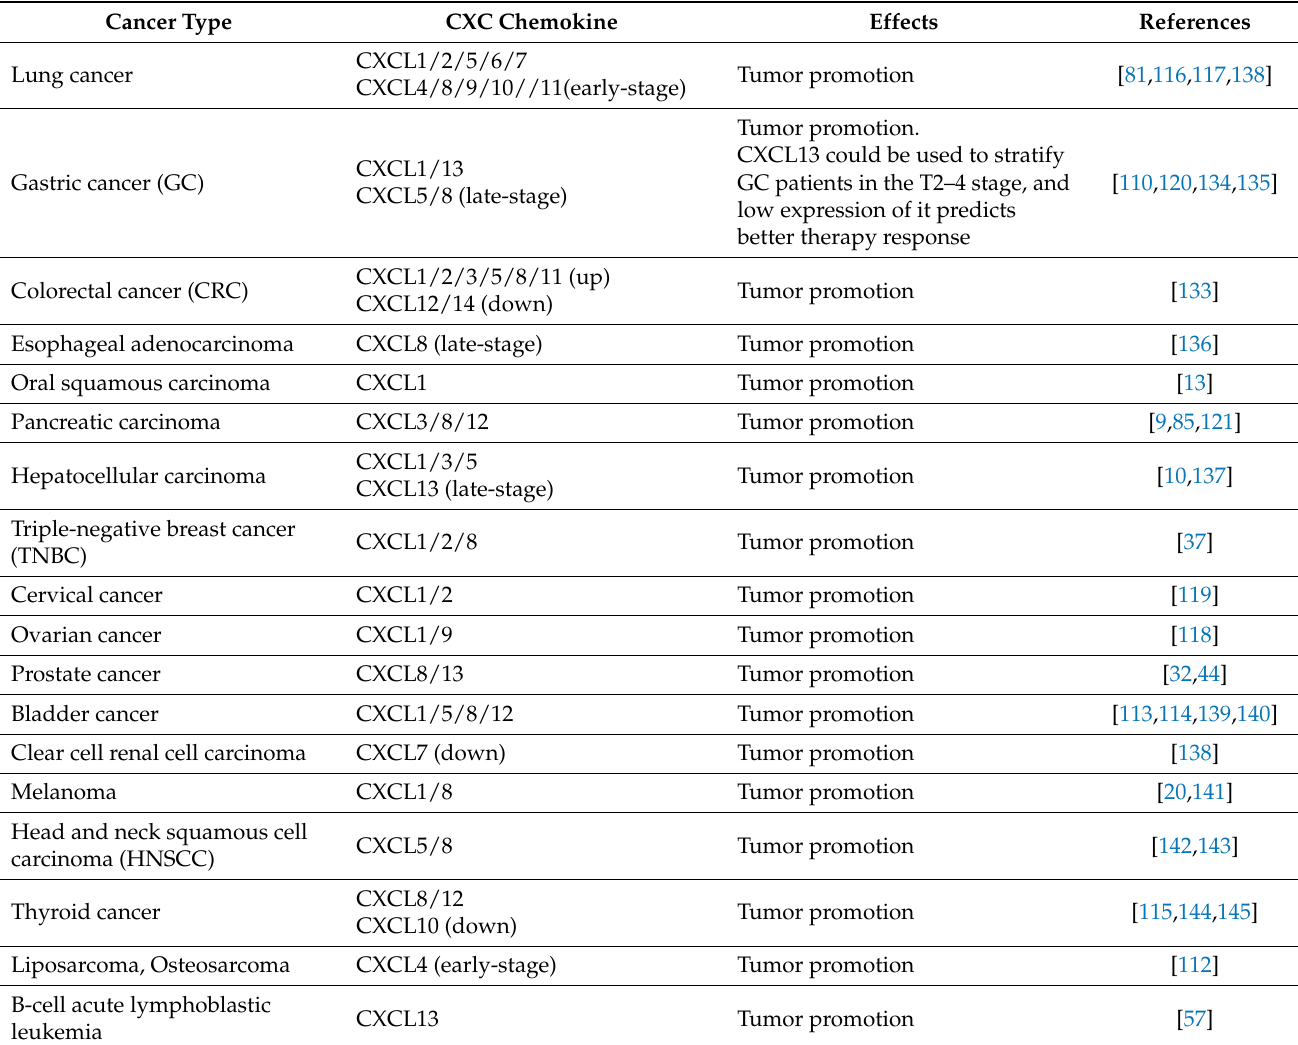
Table 4. Different cancer types and their corresponding CXC